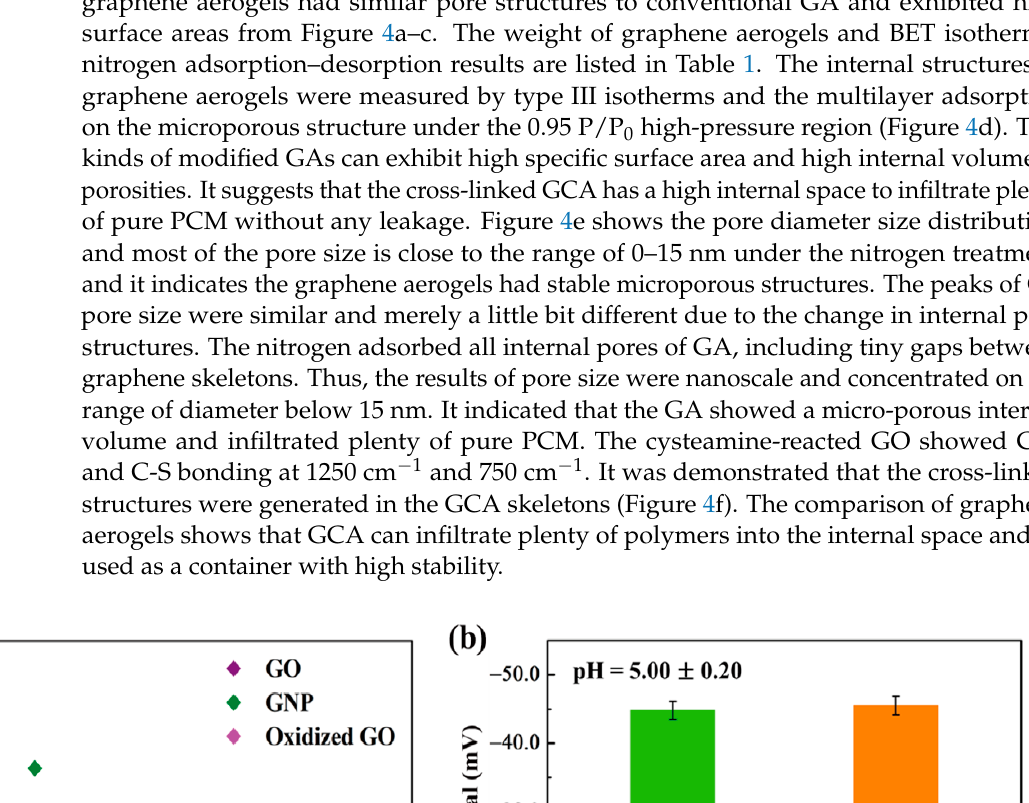
Table 1. The characterization of the graphene aerogels.